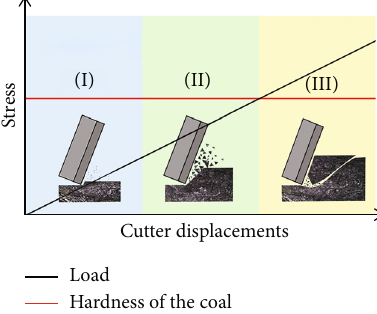
Figure 2: Crushing form of coal during